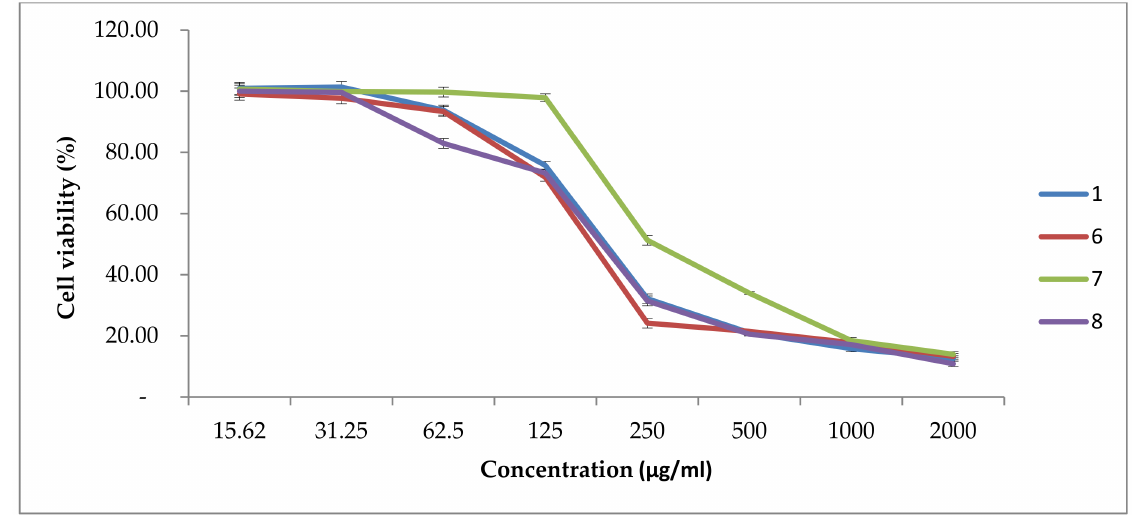
Figure 4. Antitumor activity (%) of the four fractions (1, 6, 7 and 8) from 0.44 mg/L (Zn) extract of Nostoc linckia against the promising cell line (Hela cell